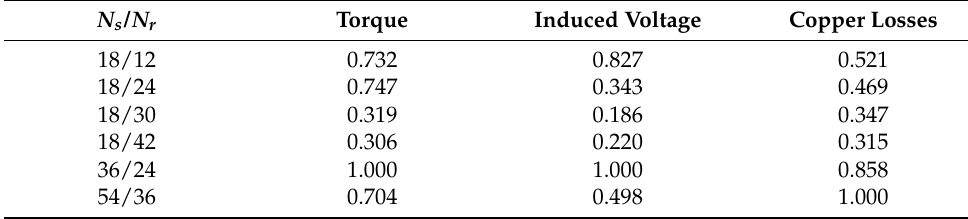
Figure 4. JMAG fractional model of 36/24 SRM. Table 5. Slot/pole configuration; normalized comparison of static characteristics.